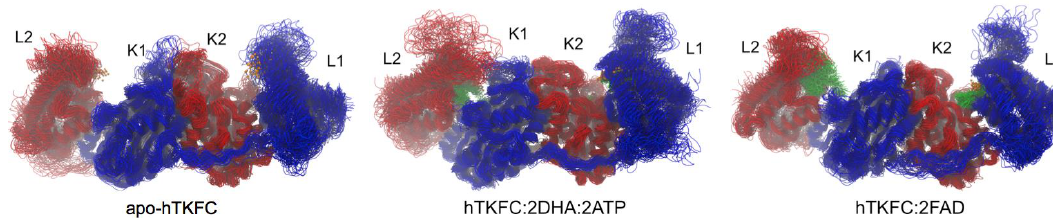
Figure 5. Molecular dynamics of hTKFC and its complexes with kinase or cyclase substrates. The figure shows the superimposition of 60 snapshots extracted from 120-ns trajectories at 2-ns intervals and aligned with the initial